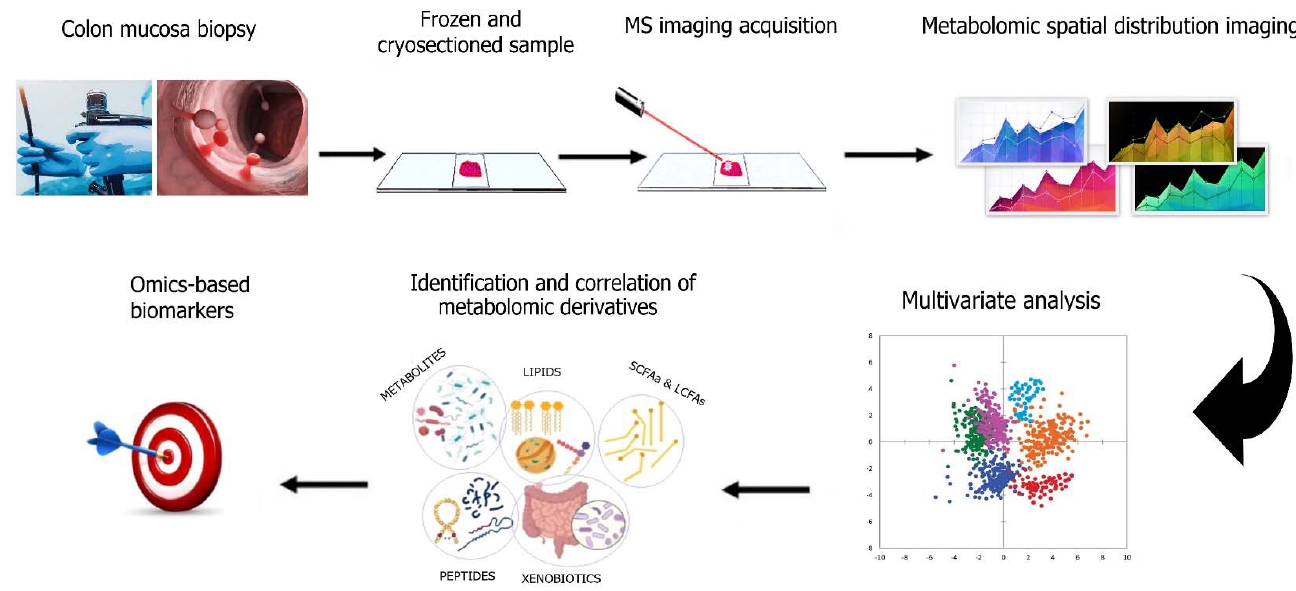
Figure 4. Overview of the MS imaging workflow towards CRC metabolomics. Preparation steps